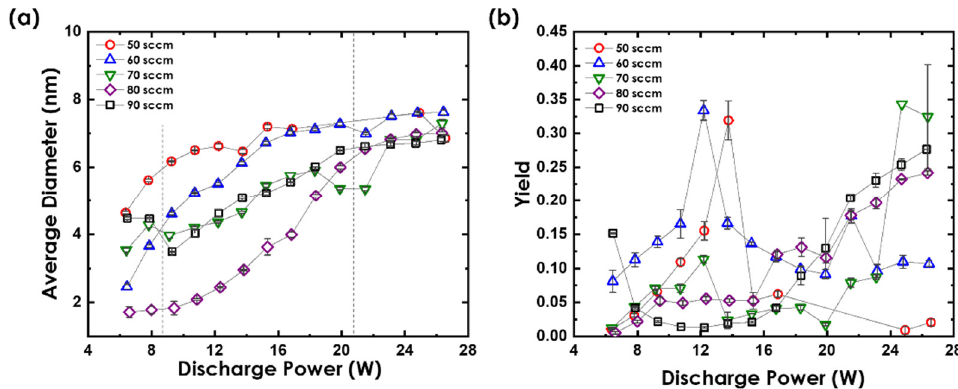
Figure 4. Impact of P on Au nanoclusters’ ( a ) average diameter and ( b ) yield presented for various f at L = 60 mm.